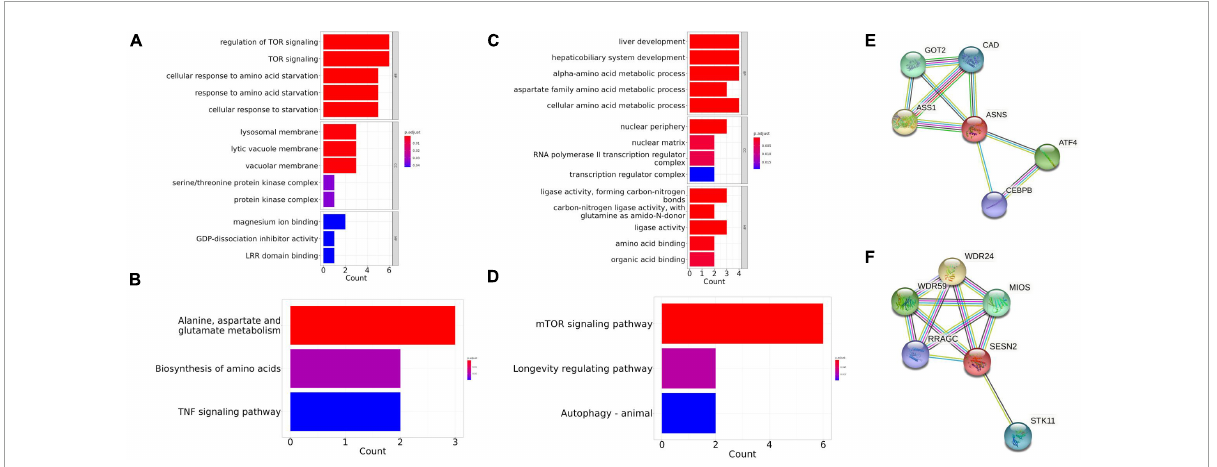
FIGURE6 Gene Ontology (GO) and Kyoto Encyclopedia of Genes and Genomes (KEGG) enrichment in the co-expressed protein network of ASNS and SESN2. (A,B) The GO and KEGG enrichment of the co-expressed protein network of SESN2. (C,D) The GO and KEGG enrichment of the co-expressed protein network of ASNS. (E) Co-expressed protein network of ASNS. (F) Co-expressed protein network of